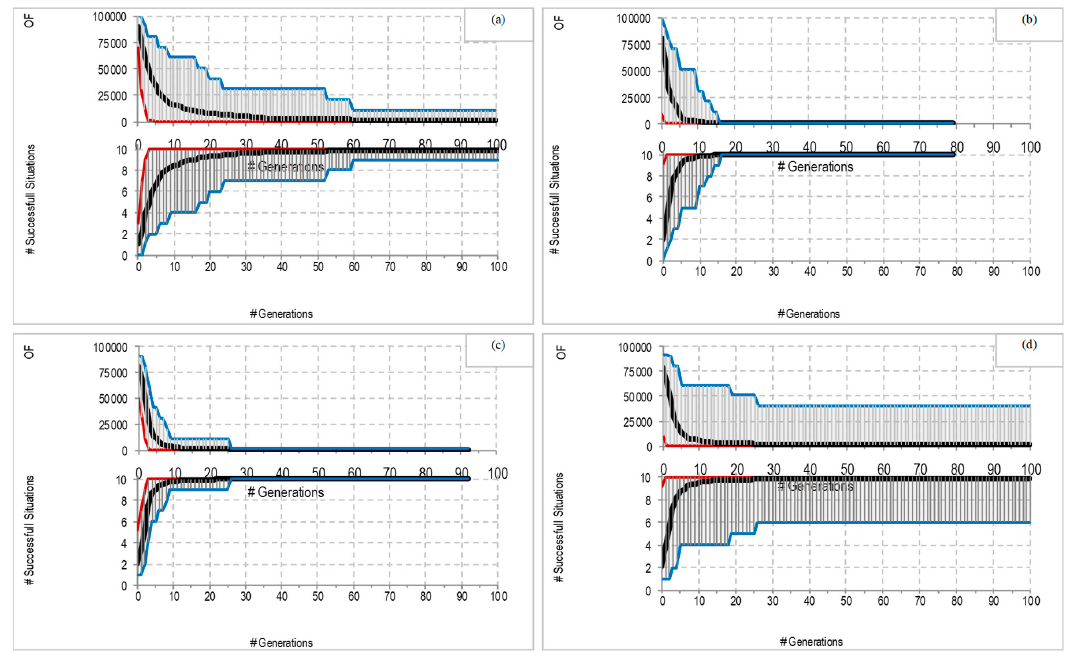
Figure 4. Convergence of the fitness for 32 runs of the GA evolving predators with sensor offset of ( a ) 10°, ( b ) 20°, ( c ) 30°, and ( d ) 40°, respectively. Table 3. Efficiency of evolution of the team of predator